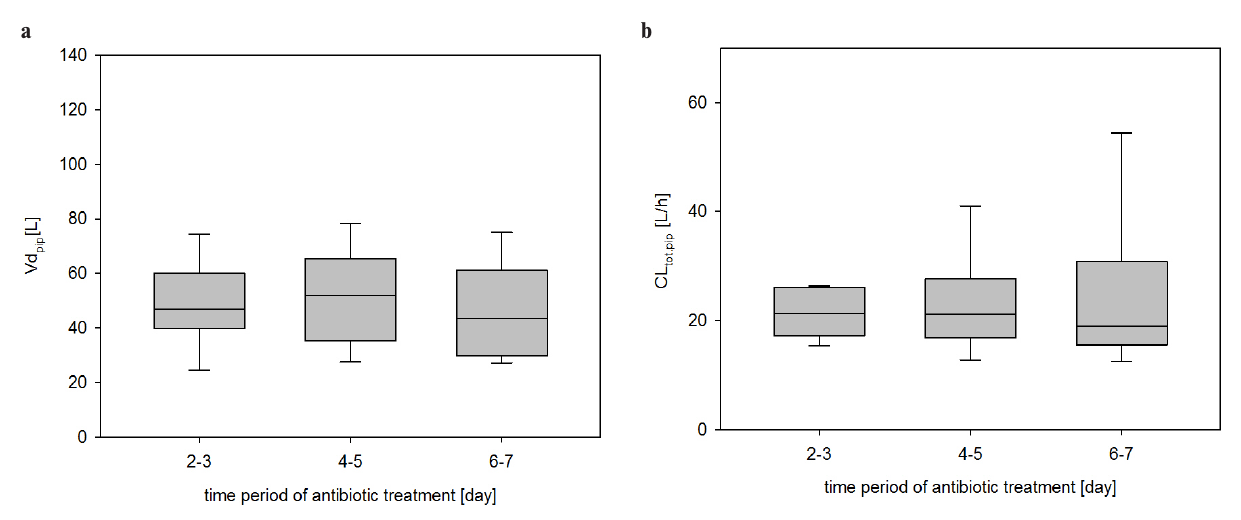
Data presented as Median (interquartiles), P >0.05 (NS) for all